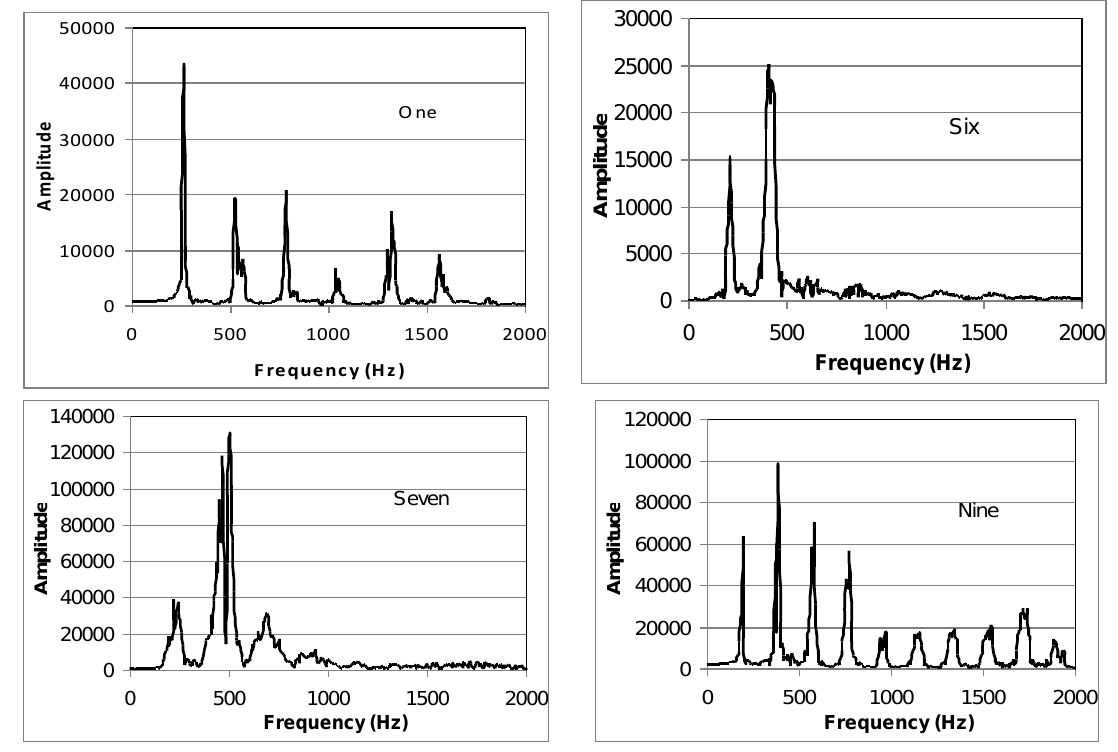
Fig. 6: Amplitude frequency spectra for voice samples from M10 while pronouncing the four words ‘One’, ‘Six’, ‘Seven’ and